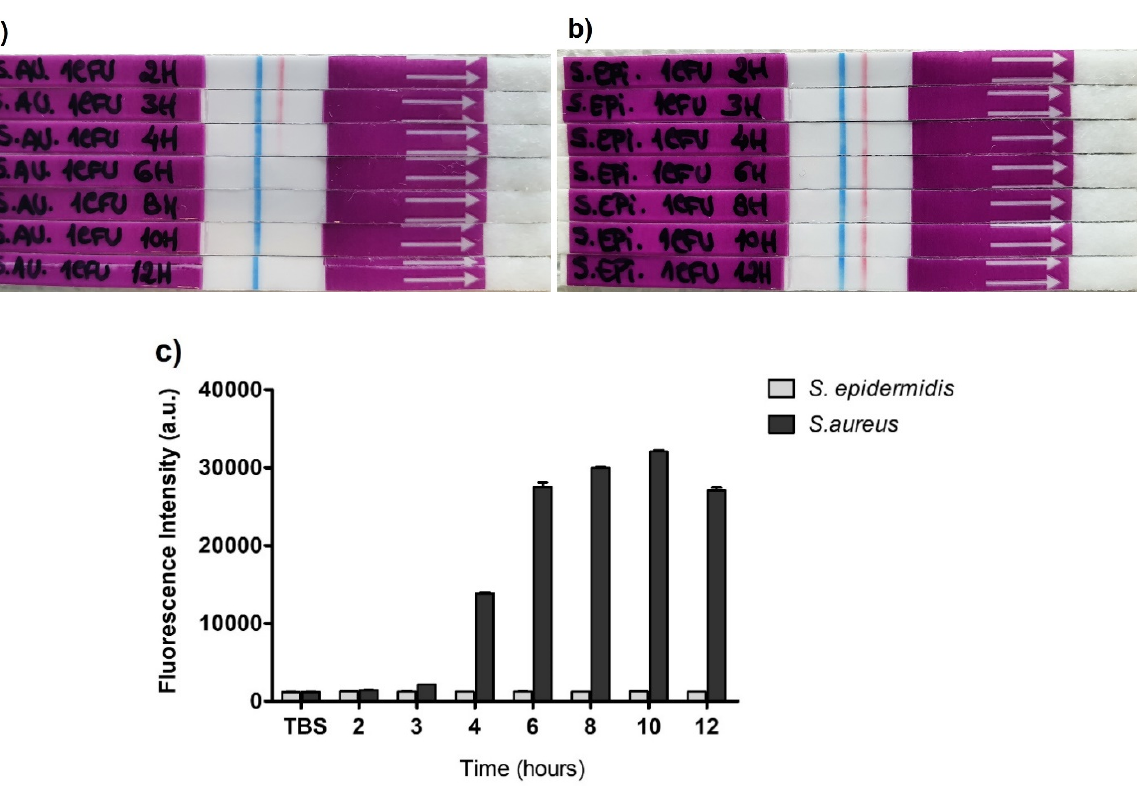
Figure 8. Detection of S. aureus ATCC 29213 in mini cultures by the lateral flow ( a , b ) and fluorescence ( c ) methods. The mini cultures were established from 1 CFU bacteria and NAA was performed at various times from 2 to 12 h. S. epidermidis was used as control bacteria. Error bars in c ) represent the avg ± stdv. of at least 3 measurements.